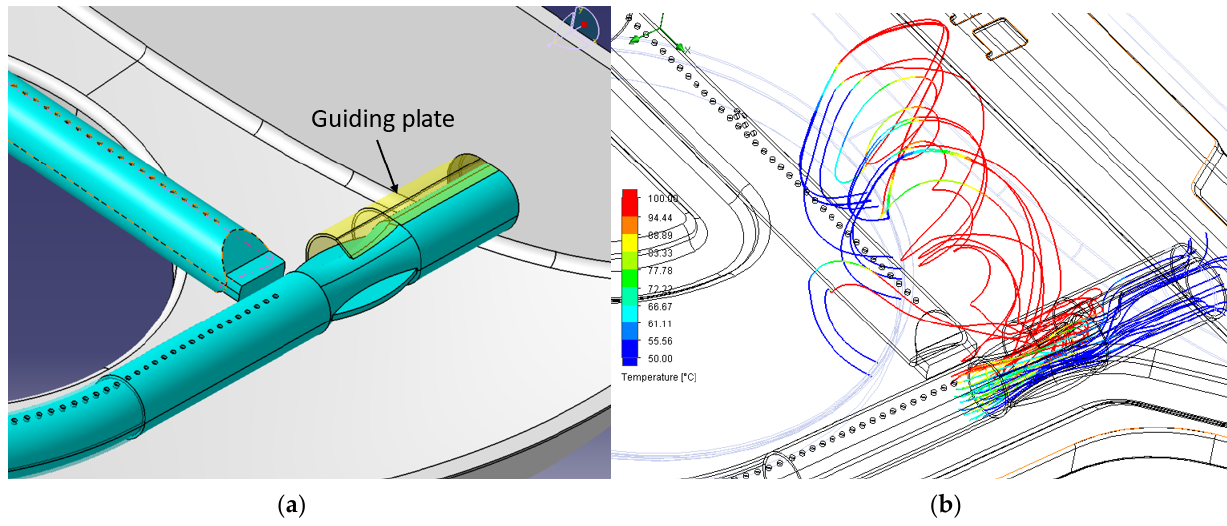
Figure 8. Improved design #1. ( a ) A guiding plate is installed in the original combustion tube; ( b ) Simulated gas analysis diagram of the improved design.